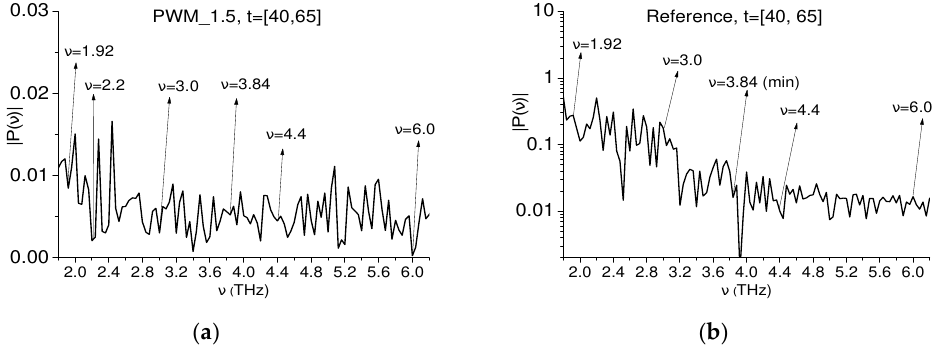
Figure 20. Spectra of the PWM_1.5 first sub-pulse ( a ) and reference in the logarithmic scale ( b ) computed in the time interval t = [40, 65] ps in the frequency range ν = [1.8, 6.2] THz. In the spectrum Figure 20a, one can see three spectral minima at the frequencies ν = 1.92, 2.2, 3.0 THz that are close or equal to the absorption frequencies of the substance RDX ν = 1.95, 2.2, 3.0 THz, respectively [2,3]. It also contains three spectral minima at the doubled frequencies ν = 3.84, 4.4, 6.0 THz. In turn, in the reference spectrum Figure 20b,